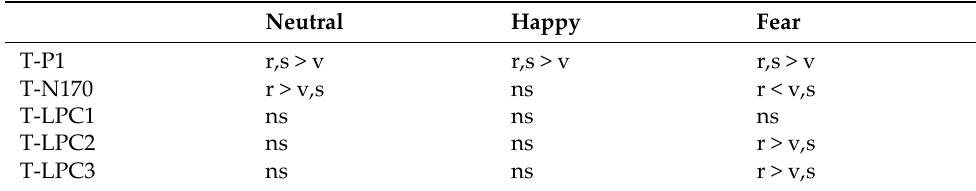
Table 1. The comparisons of ERP amplitudes of completing the MCE task under different experi‑ mental